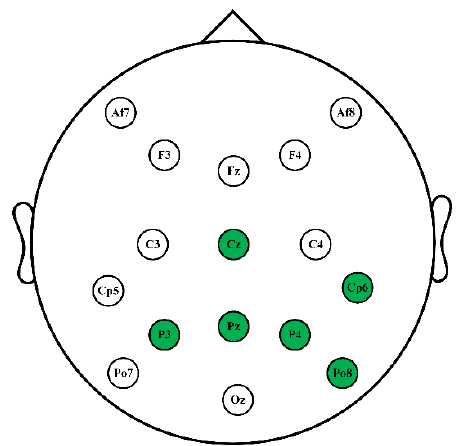
Figure 5. The most related electrodes for face image-based RSVP paradigm.